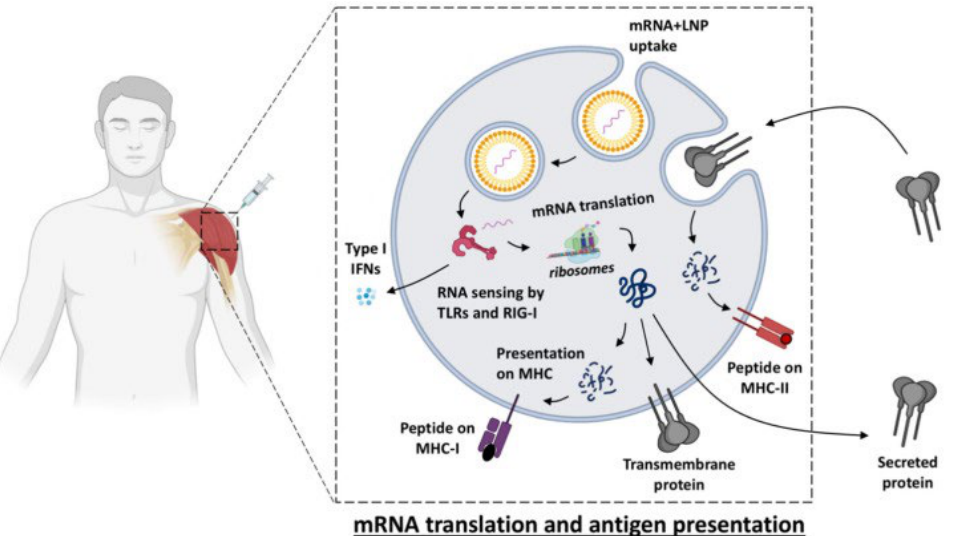
Figure 2. Vaccine uptake, translation, and biodistribution after mRNA vaccination [31]. IFNs: interferons; MHC: major histocompatibility complex; LNP: lipid nanoparticle; TLRs: toll-like receptors; RIG-1: retinoic acid-inducible gene 1 Note . Reprinted from “Immune responses induced by mRNA vaccination in mice, monkeys and humans” by Cagigi A, Loré K. Vaccines (Basel). 2021;9:61. (https://www.ncbi.nlm.nih.gov/pmc/articles/PMC7831080/). CC